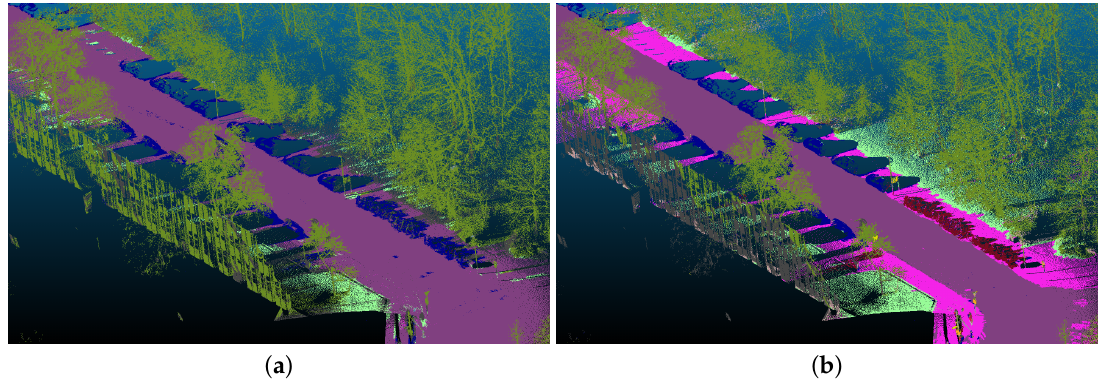
Figure 16. Semantic segmentation of 3D point clouds, using labels transferred from image segmentation, without ( a ) and with ( b ) estimated label